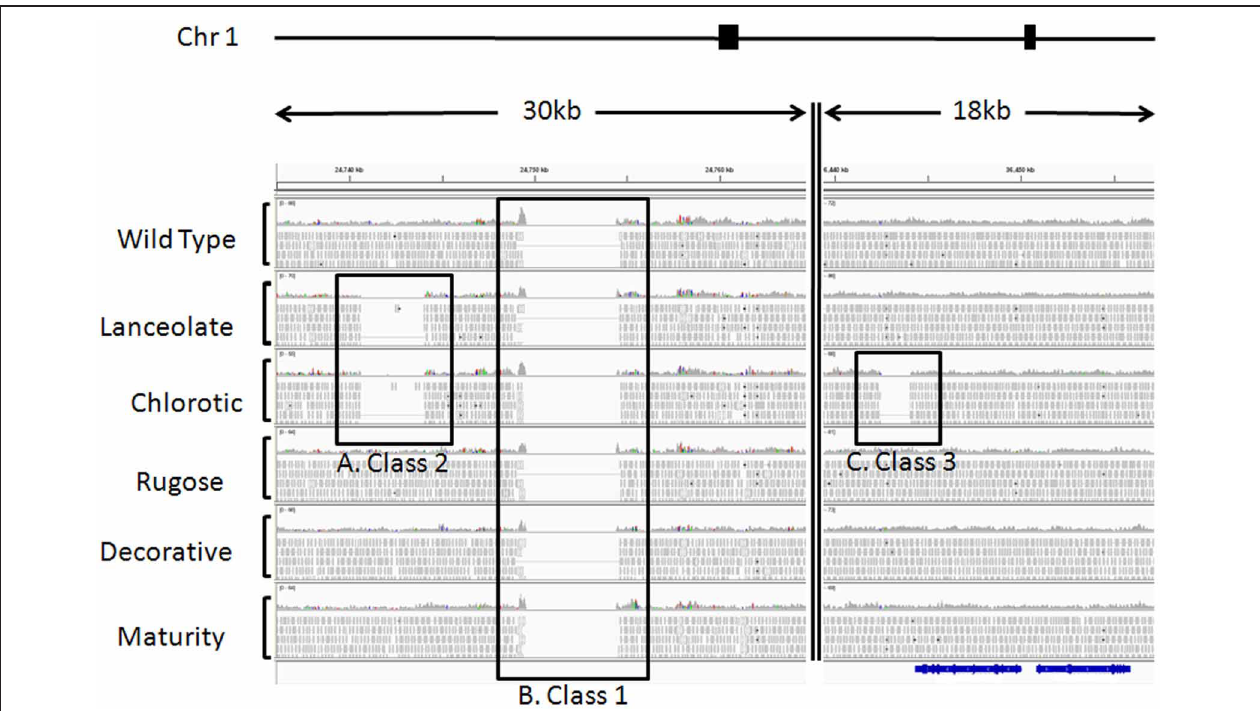
FIGURE 2 | Example of sequence alignments illustrating cultivar heterogeneity and fast neutron induced deletions. Paired end sequences from six Red Hawk individuals were aligned to the G 19833 genome sequence available at www.phytozome.net using BWA (Li and Durbin, 2009) with default parameters. Using CREST and custom perl scripts, we identified statistically significant deletions illustrating three classes of SV. SV was visualized using IGV (Robinson et al., 2011). These regions of SV were all identified on chromosome 1, from the two regions highlighted by filled black boxes above the alignments. The double vertical line within the alignments represents chromosomal region between the two genomic regions depicted. For each individual, a histogram plot illustrates the read depth with individual reads plotted below. Black boxes highlight the three classes of SV. (A) Class 2, regions of genomic heterogeneity within the Red Hawk cultivar. These